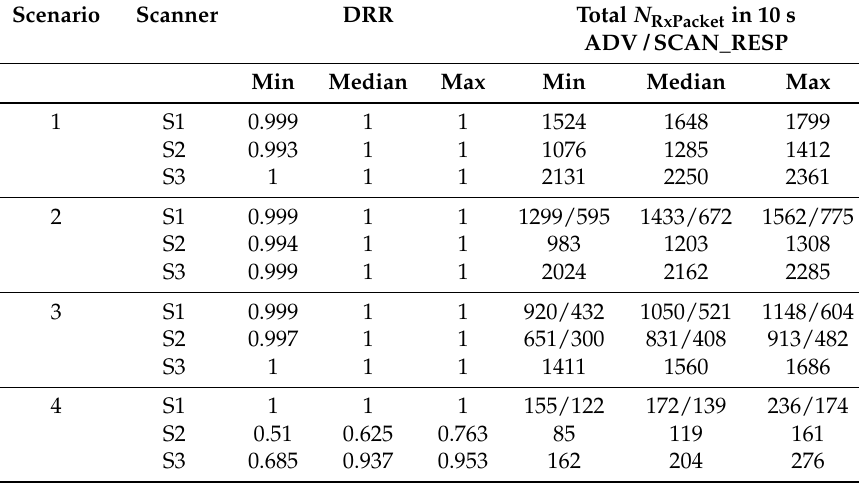
Table 6. DRR and the number of packets received (in 10 s time windows) for all the 150 nodes in the experiments, different scenarios, and scanners. For scanners operating in the active mode the number of ADV and SCAN_RESP messages are